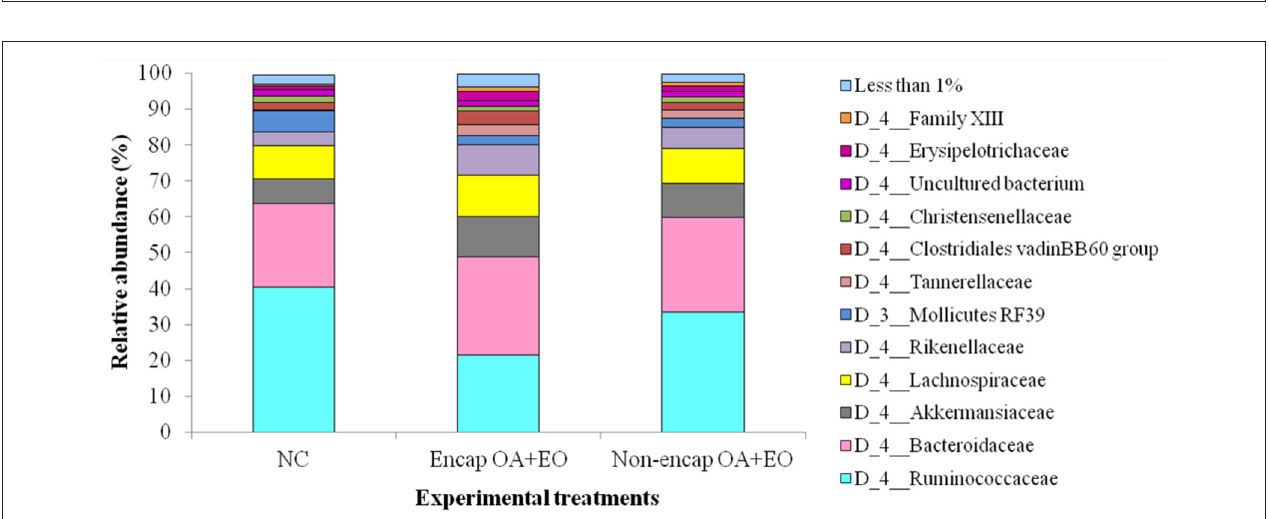
FIGURE 4 | Phyla present in the cecum microbiota of broilers from different treatment groups on day 35. NC, negative control; OA, organic acid: fumaric; EO, essential oil: thymol. Encap: microencapsulated; Non-encap, non-microencapsulated. Inclusion levels: microencapsulated fumaric acid: 1.5 g/kg; microencapsulated thymol: 3 g/kg; non-microencapsulated fumaric acid: 0.9 g/kg; non-microencapsulated thymol: 0.6 g/kg.